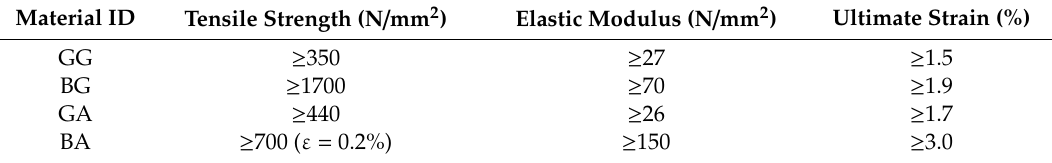
Table 4. Geometrical and mechanical properties of grids and anchors as provided by manufacturers.